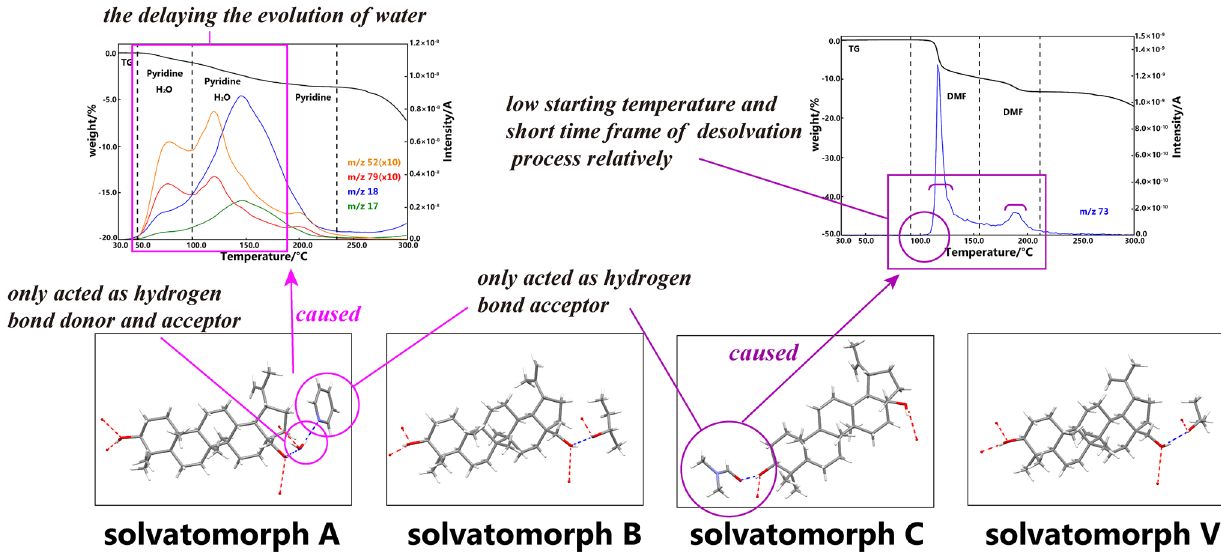
Fig. 7 Demonstration of discussion on the relationships between the desolvation behavior and intermolecular interactions in solvato- morphs of BE (the stick models of the single crystals of four solvates